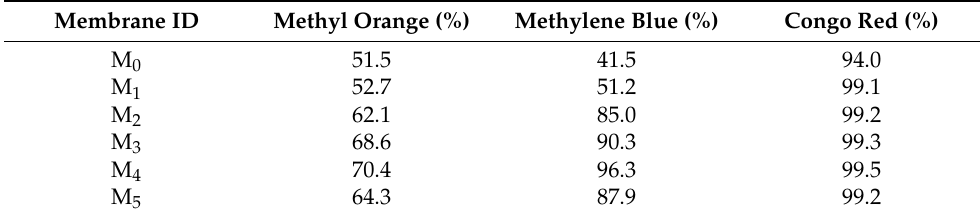
Table 4. Rejection data of the three dyes on the fabricated